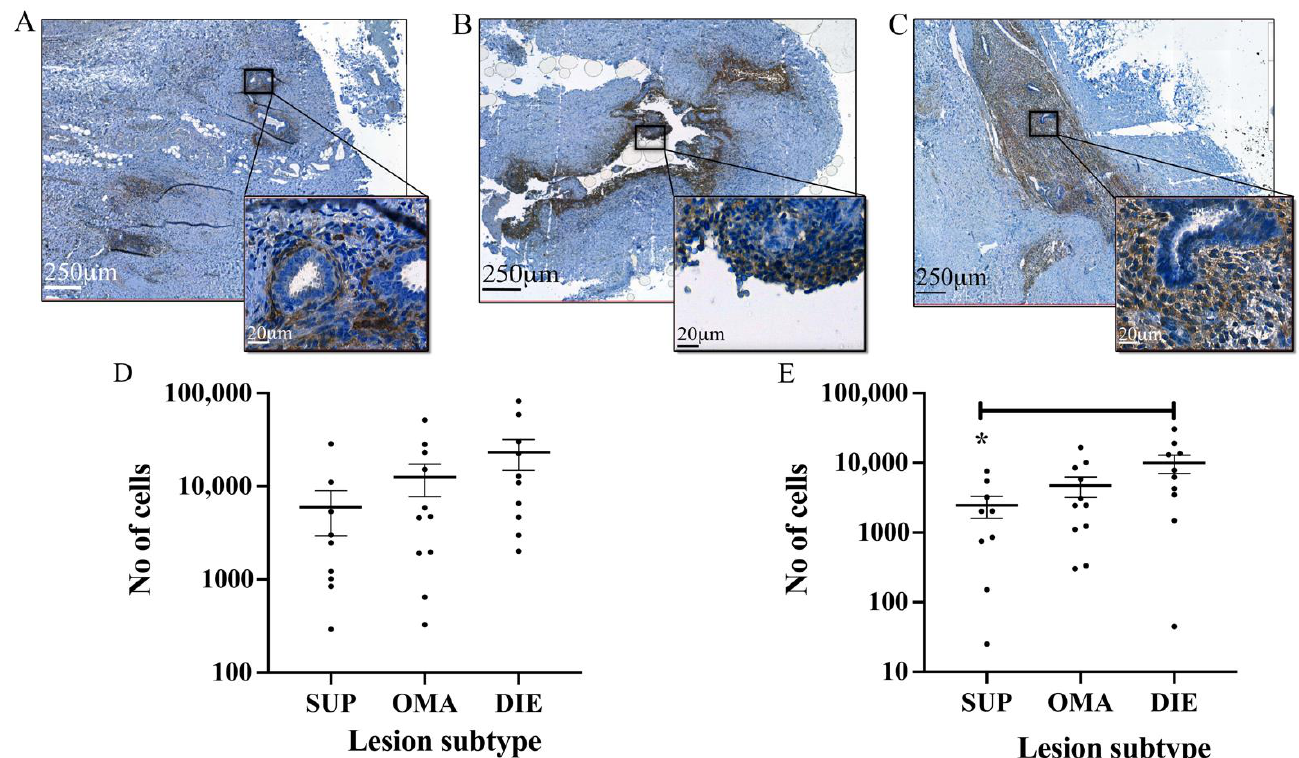
Figure 2. CD10-positive stromal cells in endometriotic lesions of different subtypes. The CD10 antibody and automated analysis of images using QuPath identified endometriotic stromal cells in lesions from ( A ) SUP, ( B ) OMA, and ( C ) DIE. ( D ) The total number of stromal cells was lowest in SUP lesions followed by OMA lesions. DIE lesions contained the largest number of stromal cells.